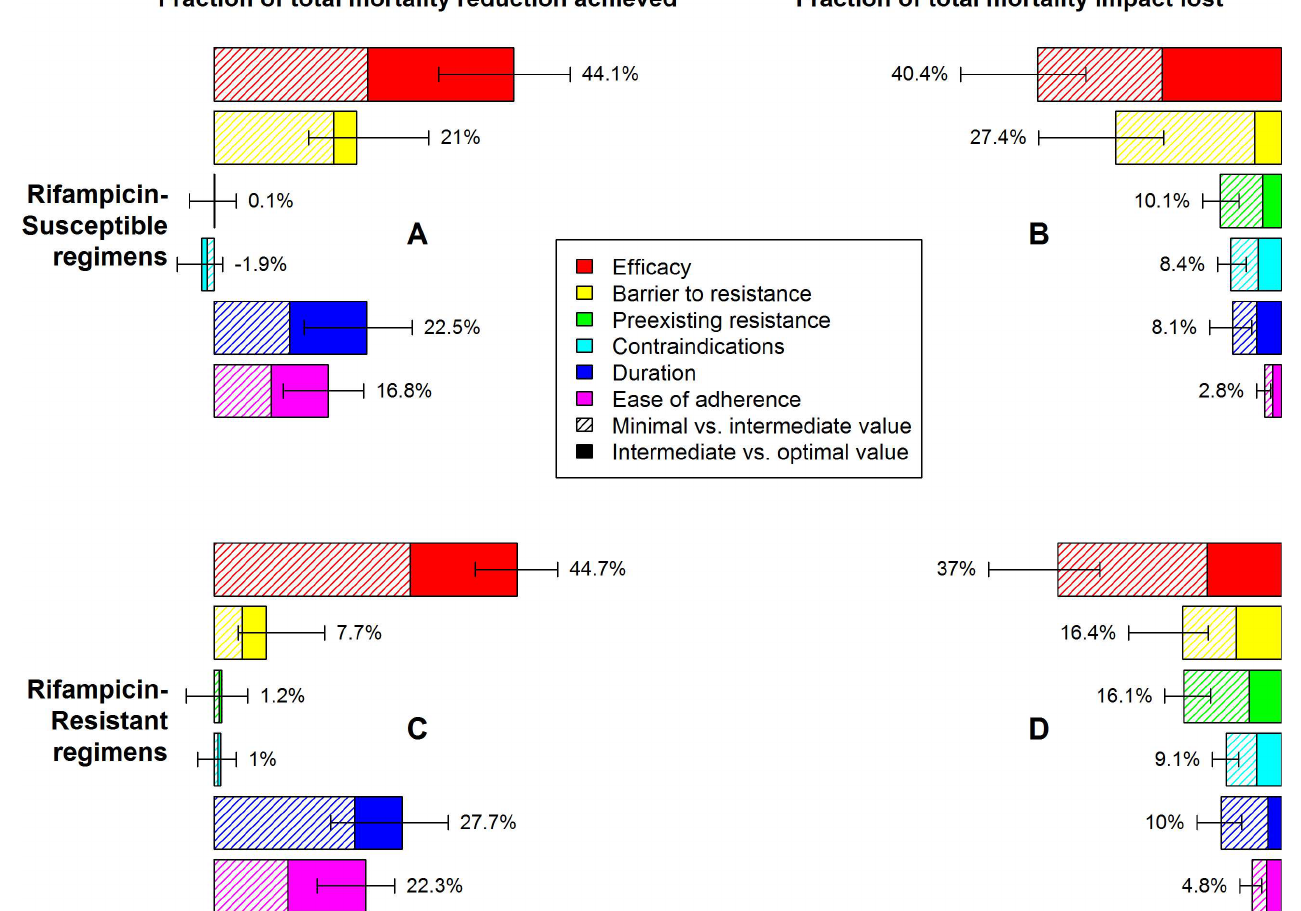
Fig 3. Relative mortality impact of different individual characteristics of novel regimens for the treatment of RS or RR TB. Characteristics and levels are definedin Table 1. Impact is measuredas a relative changein TB mortality (RS TB regimen, A and B) or RR TB mortality (RR TB regimen,C and D) 10 y after introduction of the novel regimen, as illustrated in Fig 3. In A and C, the benefit of partially (striped bars) or fully (solid bars) optimizingonly one aspect of a regimen, with the remainingcharacteristics meetingonly minimaltargets, is comparedto the impact of a regimen that is fully optimizedin all aspects. In B and D, the mortality reductionachievable by a regimenthat fails to meet only one optimistic target (relative to mortality projections using standardregimens) is compared to mortality reductionwith a regimen that meets all optimistictargets. Percentages need not sum to 100% due to synergy betweenmultiple characteristics of the regimen. Error bars show the 95% UR for the impact of each fully optimizedcharacteristic.